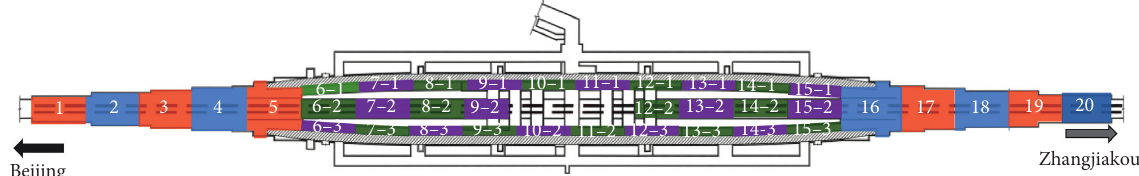
Figure 6: Scan survey area delineation at the Great Wall